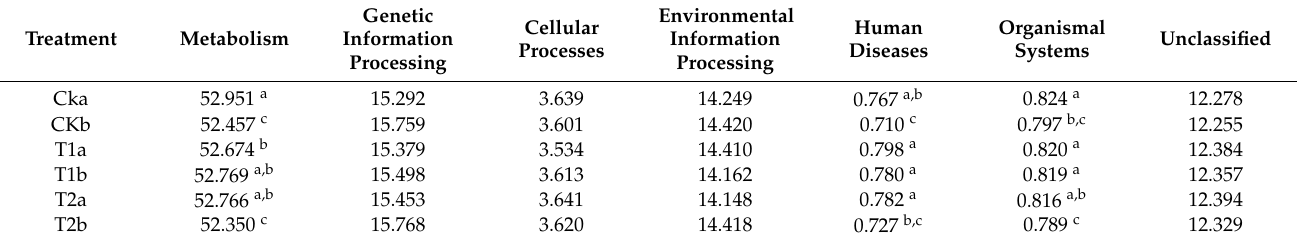
Table 4. Functional abundance in biochemical metabolic pathways of bacterial community of each